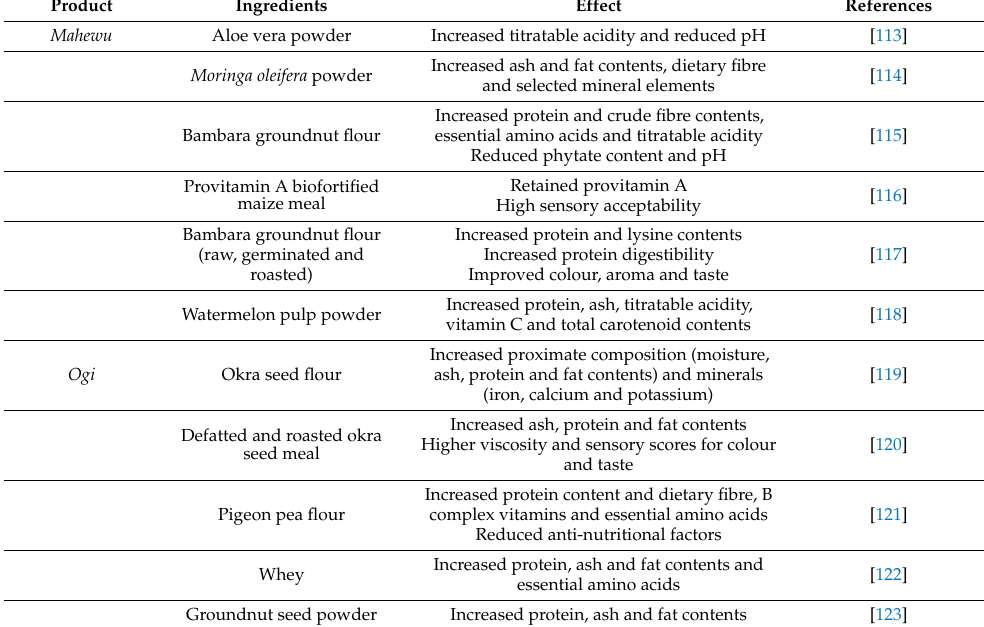
Table 3. Effects of ingredients on the nutritional and quality properties of maize-based non-alcoholic fermented